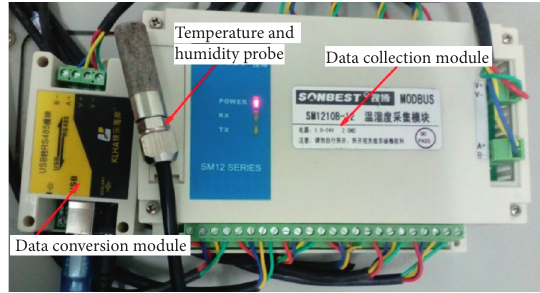
Figure 4: Temperature and humidity measurement system.